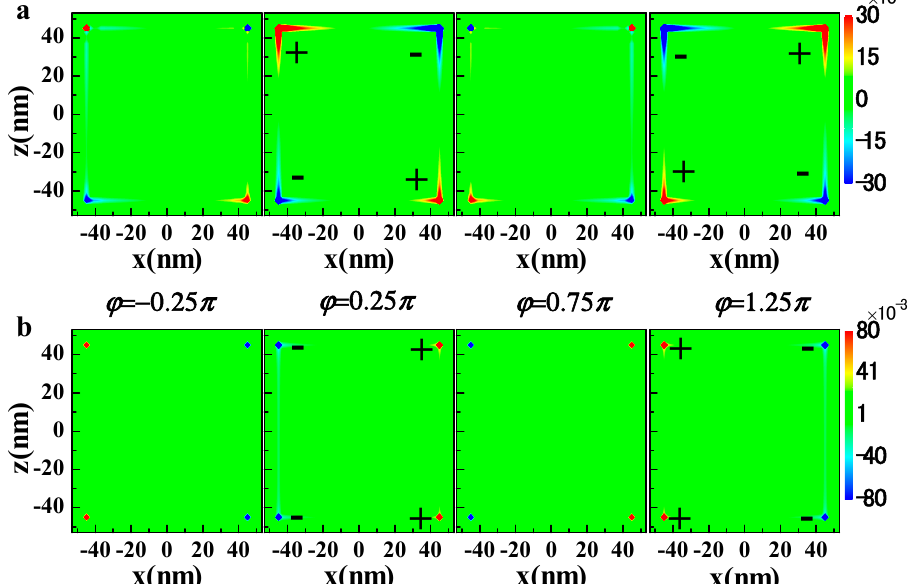
Figure 3. The influence of CEP on the surface charge distribution of a 90 nm silver nanocube. ( a ) Quadrupole mode at λ = 447 nm and ( b ) Dipole mode at λ = 643 nm with ϕ = − 0.25 π , 0.25 π , 0.75 π and 1.25 π .